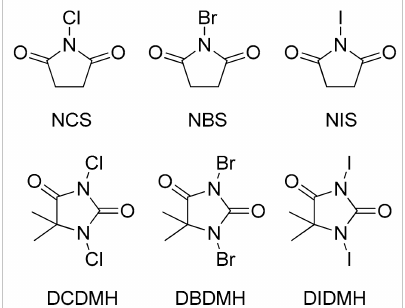
Figure 2. Structures of N -halosuccinimides and 1,3-dihalo-5,5-dimethylhydantoins (NCS: N -chlorosuccinimide, NBS: N